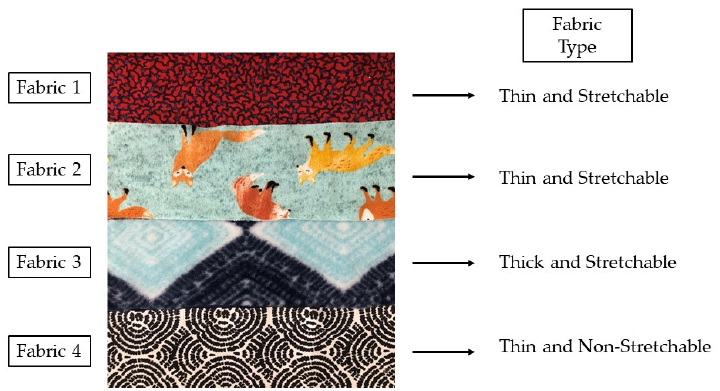
Figure 4. Fabrics tested for the embedding of the FSR and the realization of the wristband for touch-based collaborative digital gaming.